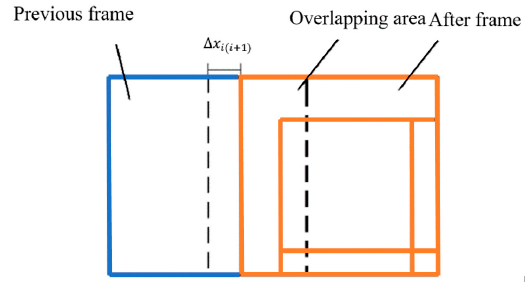
Figure 7. Schematic diagram of mechanical displacement error calculation.